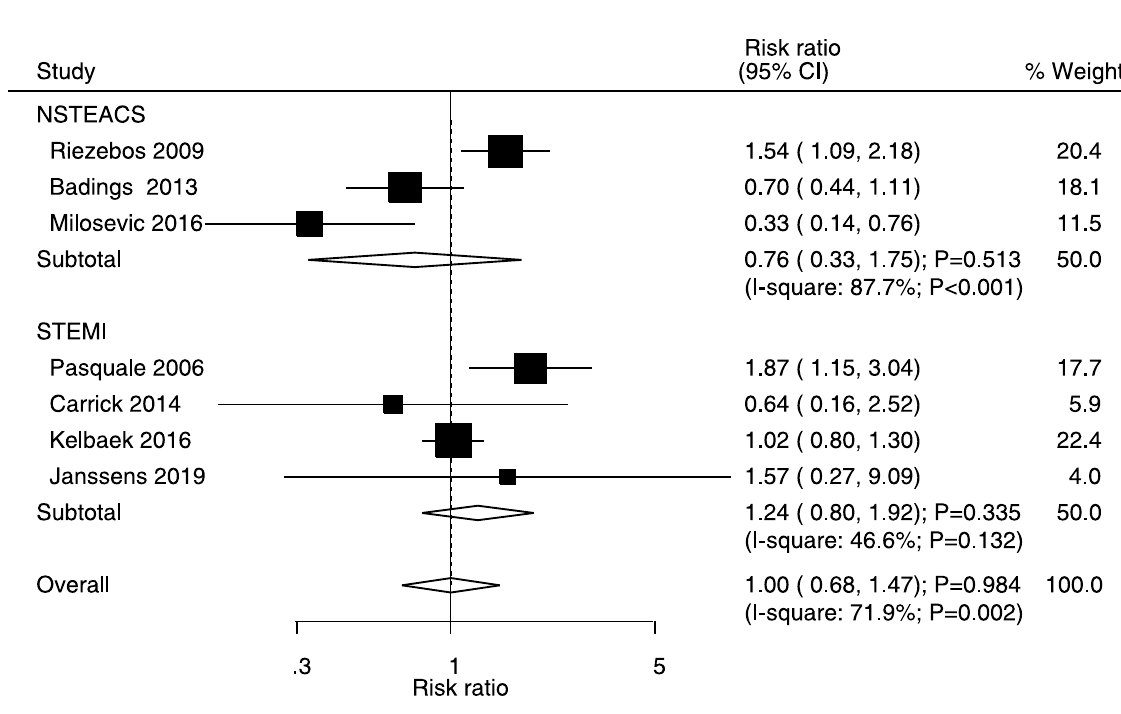
Fig 2. Immediate versus deferred PCI for major adverse cardiovascular